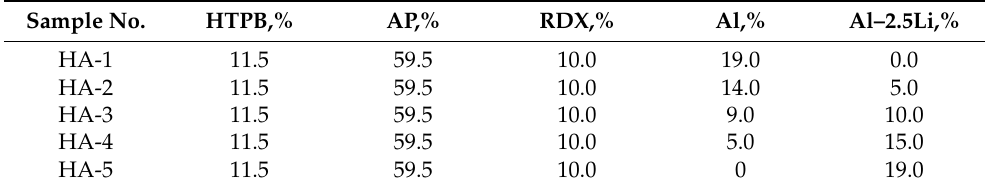
Table 1. Formulation of prepared propellants. Sample